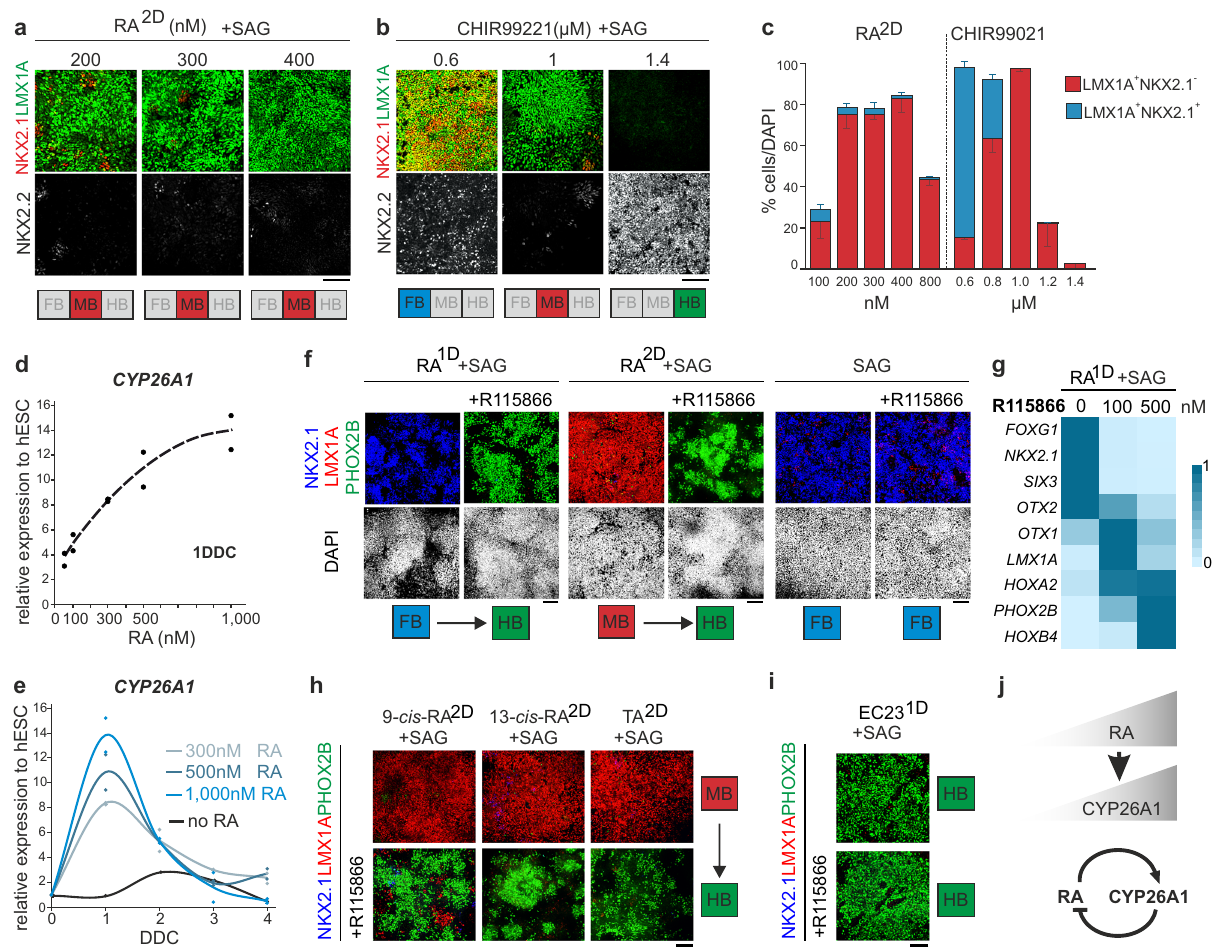
Fig. 3 A RA-CYP26 regulatory loop is central for robust RA-mediated patterning response. a – c Effect of changes in RA ( a ) or CHIR99021 ( b ) concentration on the expression of markers de fi ning ventral forebrain (NKX2.1 + LMX1A + ), midbrain (NKX2.1 − LMX1A + ) or hindbrain (NKX2.2 + ) in 9 DDC cultures differentiated in dSMADi + SAG, and corresponding quanti fi cation of NKX2.1 + LMX1A + and NKX2.1 − LMX1A + populations ( n = 3 independent differentiations per condition). values, mean ± S.D ( c ). d Effect of RA concentration (50, 100, 300, 500, and 1000 nM RA) on CYP26A1 expression in 1 DDC cultures differentiated in dSMADi (data from two independent differentiations). e Temporal expression pro fi le of CYP26A1 in cultures differentiated in dSMADi and pulsed with no RA or 300, 500, or 1000 nM of RA for 2 days (data from two independent differentiations). f Effect of inhibition of CYP26 activity with 500 nM R115866 inhibitor on the expression of NKX2.1, LMX1A, and PHOX2B at 9 DDC in cultures differentiated in SAG and indicated RA conditions. g Relative gene expression of indicated genes in 9 DDC cultures differentiated in RA 1D + SAG condition and in the presence of